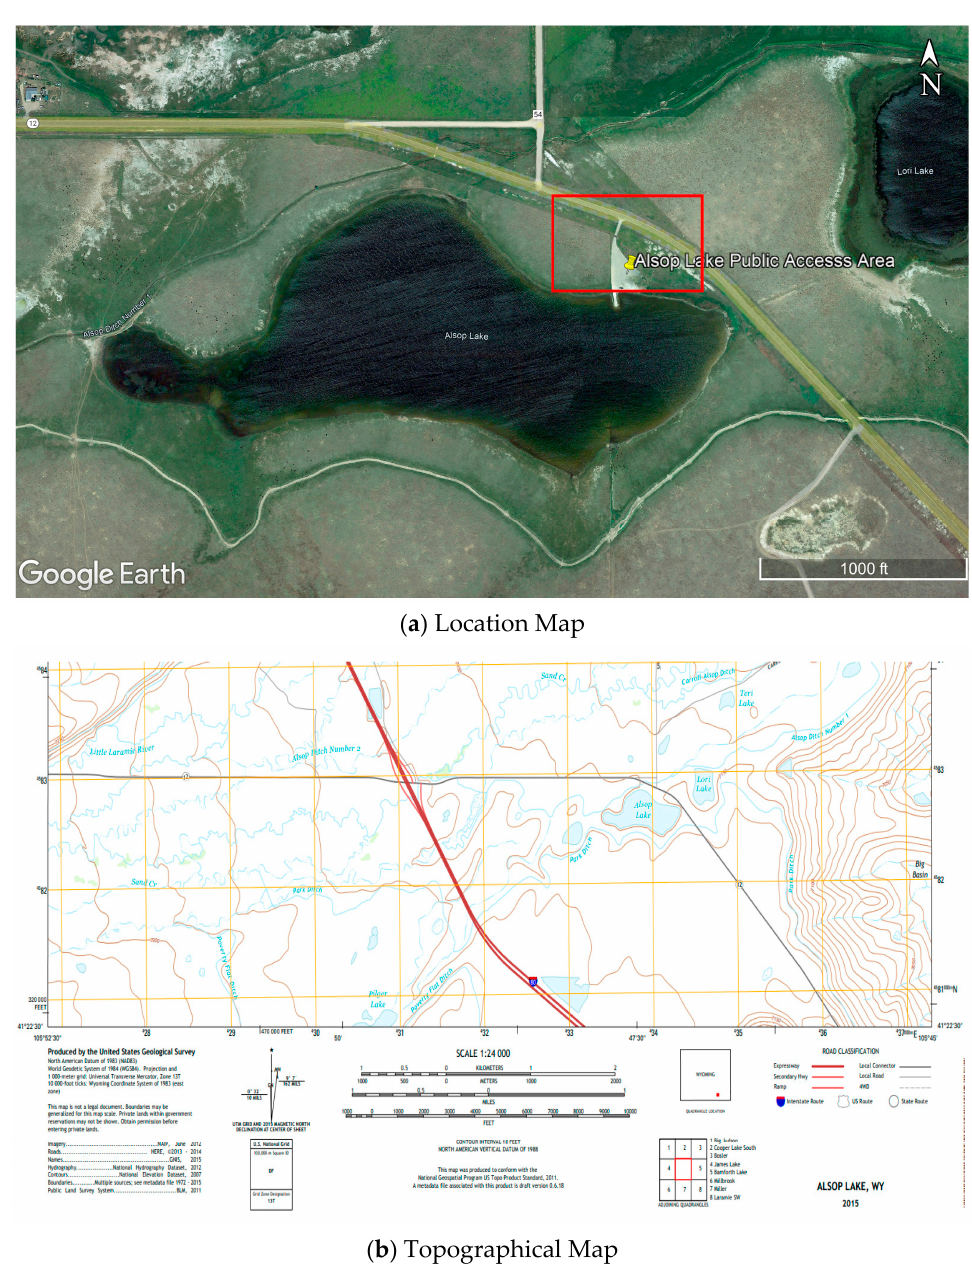
Figure 1. Location and Topographical representation of the site: ( a ) Location Map (Imagery ©2023 CNES/Airbus, Maxar Technologies, USDA/FPAC/GEO, Map data ©2023, reproduced with permission from Google, 2023); ( b ) Topographical Map (reproduced with permission from United States Geological Survey (USGS), 2015) Weather Conditions.